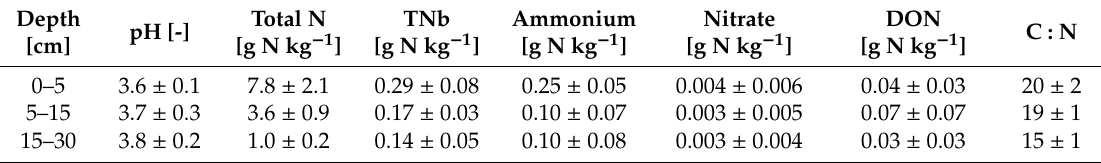
Table 2. Soil characteristics with ± denoting SD. DON stands for dissolved organic